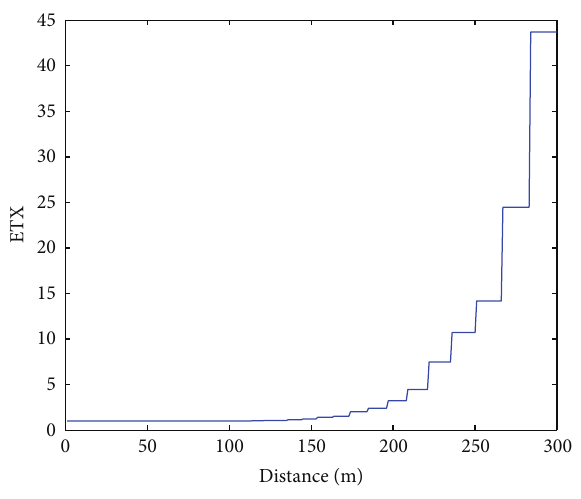
Figure 1: ETX metric via distance.